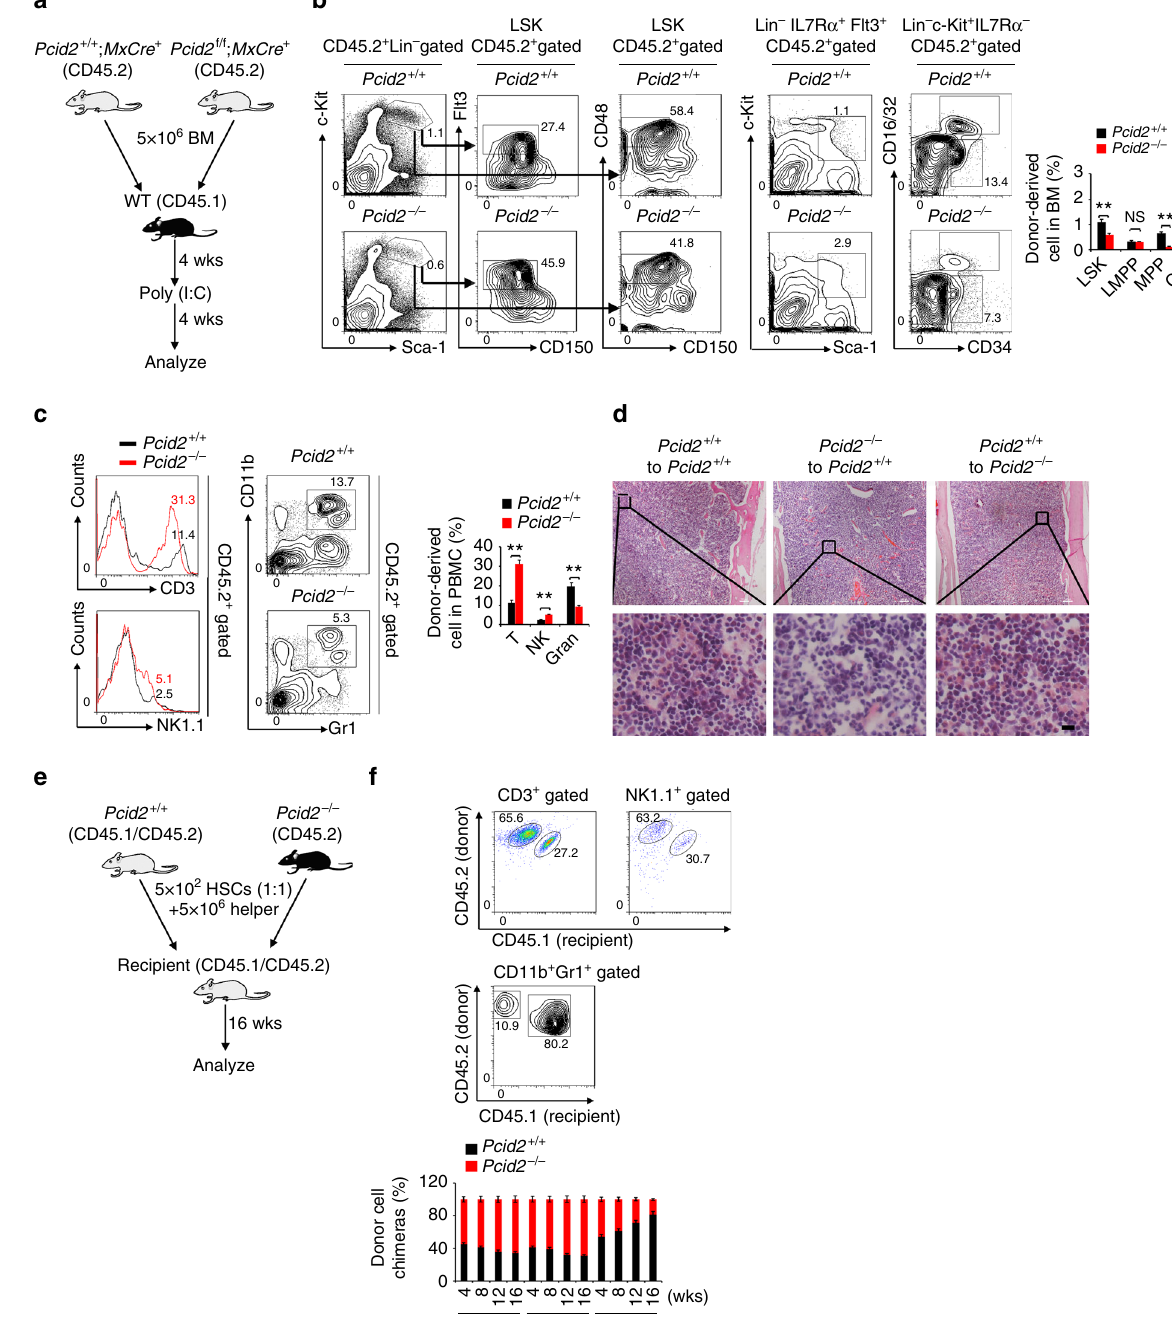
Fig. 3 Pcid2 de fi ciency-mediated bias of lymphoid lineage commitment is cell intrinsic. a Schematic representation of transplantation. BM cell populations of recipient mice were analysed 8 weeks after transplantation. b Flow cytometric analysis of LSKs, MPPs, LMPPs, CLPs and CMPs from the BM of donor mice. Percentages of the indicated progenitor cells are shown as means ± S.D (right panel). n = 6 for each group. ** P < 0.01. c Flow cytometric analysis of T cells, NK cells and granulocytes from the peripheral blood of donor mice. n = 6 for each group. ** P < 0.01. d Representative paraf fi n sections from the femurs of the indicated recipient mice were stained with H&E. Scale bars, 20 μ m. e Schematic representation of competitive BM transplantation. 1:1 mixture of CD45.1 + CD45.2 + wild-type and CD45.2 + Pcid2 − / − HSCs was transplanted into lethally irradiated CD45.1 + /CD45.2 + recipients together with 5 × 10 6 helper BM cells. BM cell populations of recipient mice were analysed 16 weeks after transplantation. f Flow cytometric analysis of the indicated cells from peripheral blood of donor mice. Ratios of CD45.1 + CD45.2 + to CD45.2 + T cells, NK cells and granulocytes in chimeras were analysed and shown as means